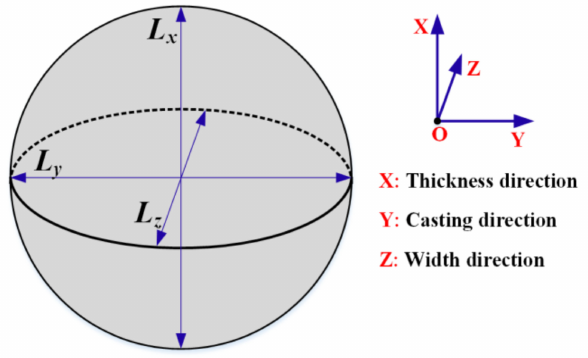
Figure 9. Schematic of the porosity dimension along three axis